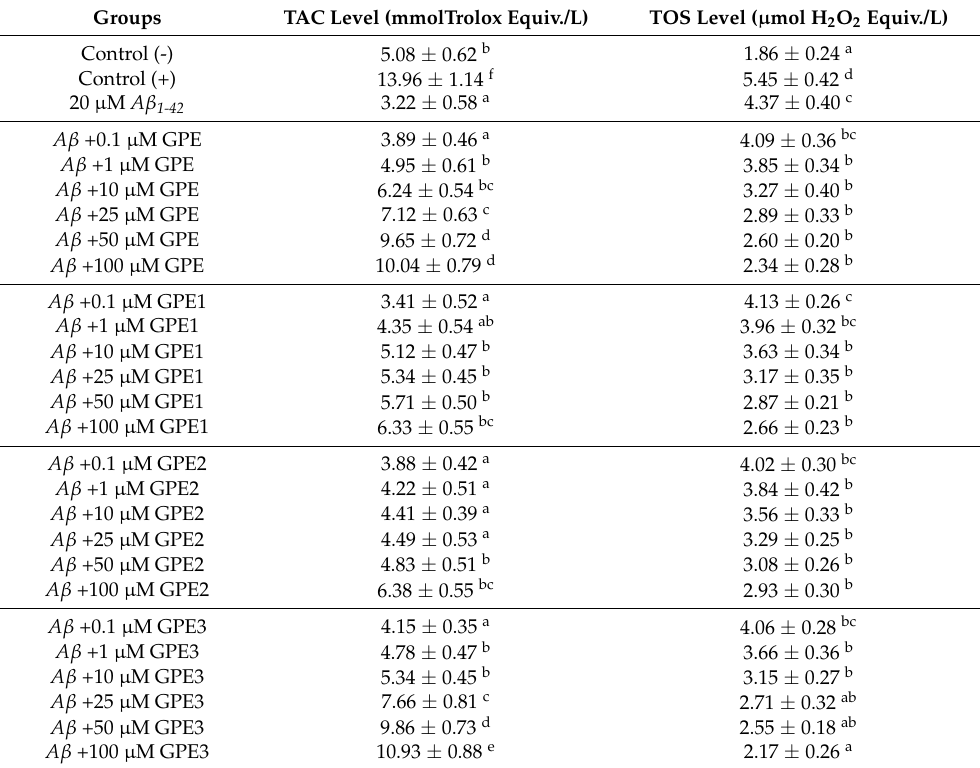
Table 4. The effects of GPEs on TAC and TOS levels in a cellular experimental model of AD (n = 5). Statistical analysis was performed using one-way ANOVA followed by Tukey’s post-hoc test. Means with the same letter in the same column are not significantly different at p =